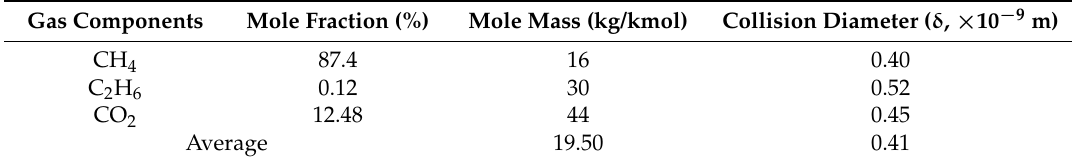
Table 1. Mole fraction, mole mass and collision diameter for each component in typical shale gas reservoir.